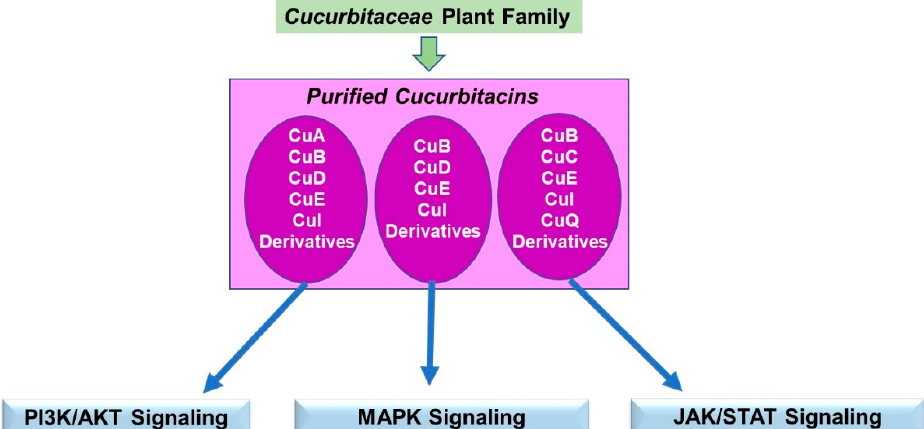
Figure 9. A schematic summary of the effects of metabolites from the Cucurbitaceae on the MAPK, PI3K/AKT, and JAK/STAT signal transduction